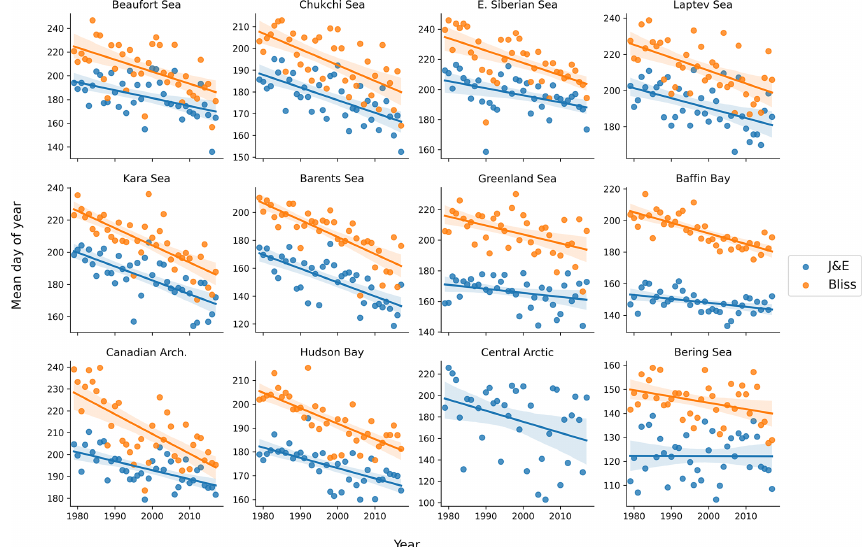
Figure 6. Yearly values of J&E’s breakup end date (blue symbols) and the Bliss et al. (2019) day of retreat (orange symbols) in the various MASIE regions. Corresponding trend lines are shown in each panel. (For the central Arctic region, the Bliss et al. (2019) “day of retreat” metric is not shown because it was defined for fewer than half the years.) The y -axis labels represent day of the year. Date scales on the y axis vary among panels in order to optimize the display of data points. For numerical values of slopes and significance levels, see Table S2.